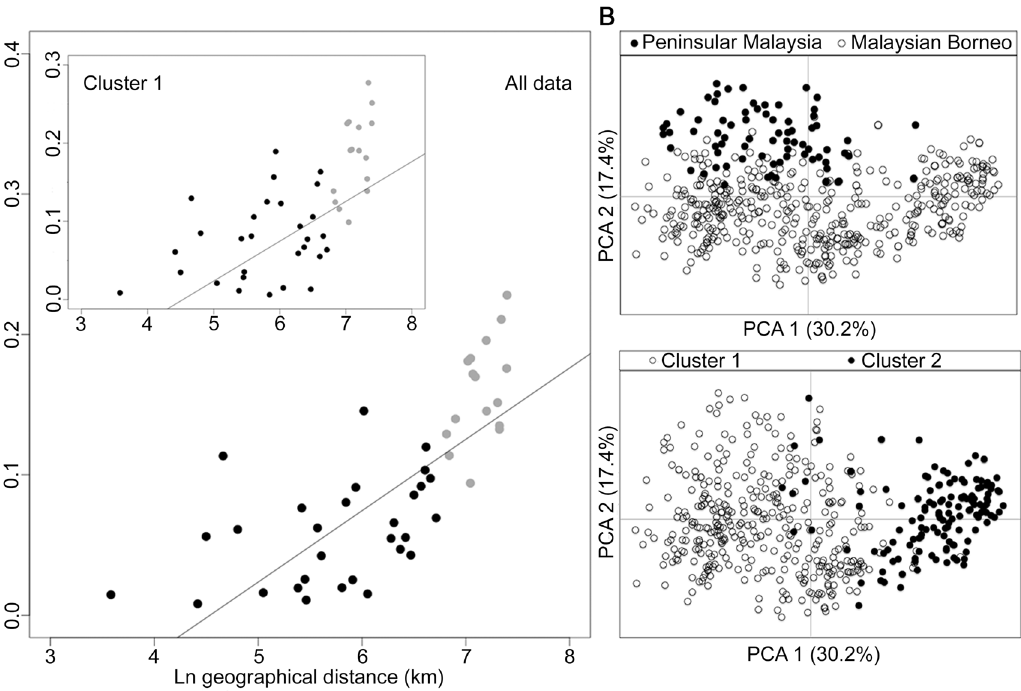
Fig 6. Isolation-by-distance model and principal component analysis (PCA) of the human P . knowlesi isolates. (A) Relationship between transformed genetic differentiation and natural log of geographical distance (Euclidean distances of population pairs ranged from 36 km to 1631 km) for all pairs of sites across Malaysia (Mantel test of matrix correlation P < 0.0001), with a similar relationship when analysing only isolates from the Cluster 1 subpopulation (Mantel test P = 0.0016). Black dots denote pairs of populations within Malaysian Borneo and Peninsular Malaysia, while grey dots denote pairs of populations between Malaysian Borneo and Peninsular Malaysia (all data are given in S6 Table). Evidence of isolation by distance remained when only sites within Borneo were considered (Mantel test P = 0.0016). (B) PCA of the whole infection haplotype dataset indicated differentiation of Peninsular Malaysia isolates from Malaysian Borneo isolates by the second principal component axis, whereas isolates defined as Cluster 1 and Cluster 2 by STRUCTURE analysis were almost completely differentiated along the first principal component